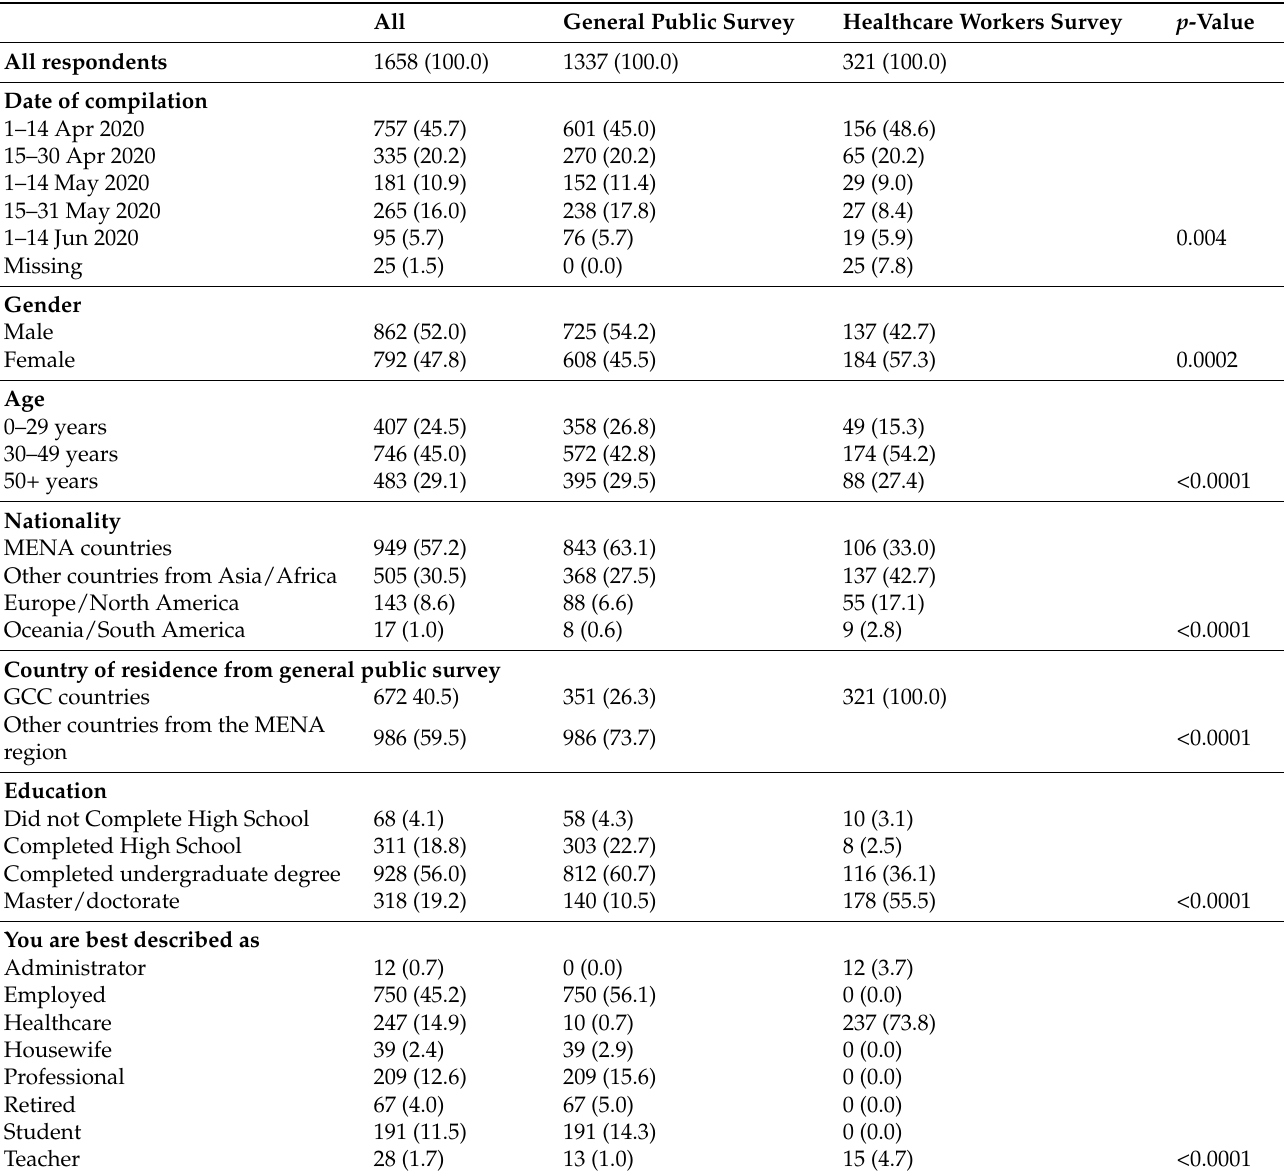
Table 1. Characteristics of respondents to the general public and healthcare workers surveys.